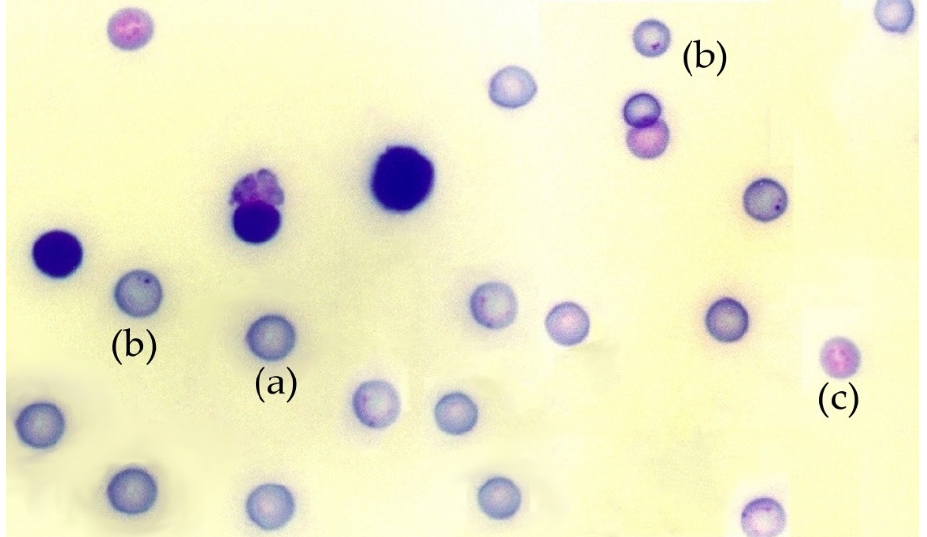
Figure 1. Photomicrograph of a mouse bone marrow smear stained with May-Grünwald-Giemsa: ( a ) polychromatic erythrocytes, ( b ) a micronucleus in polychromatic erythrocytes, ( c ) normochro- matic erythrocytes.